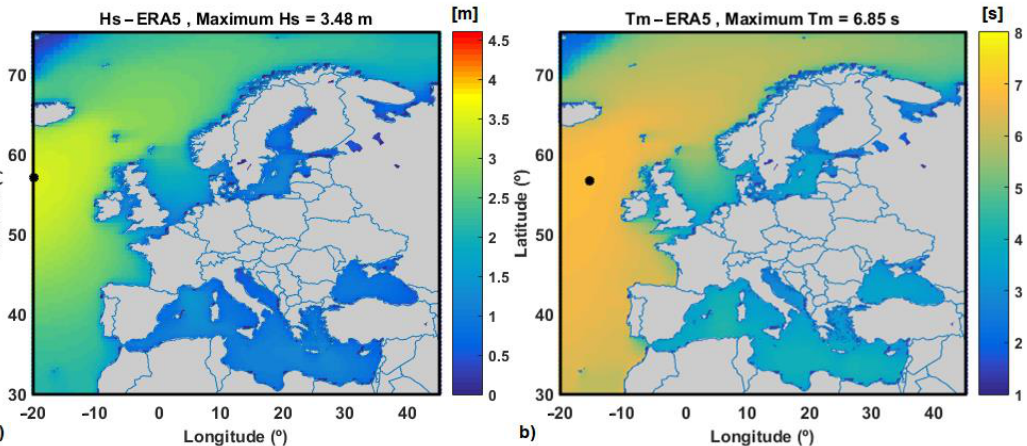
Figure 14. Mean wave conditions for the Europe region in the period 2001 – 2020: ( a ) Wave heights; ( b ) Wave periods.